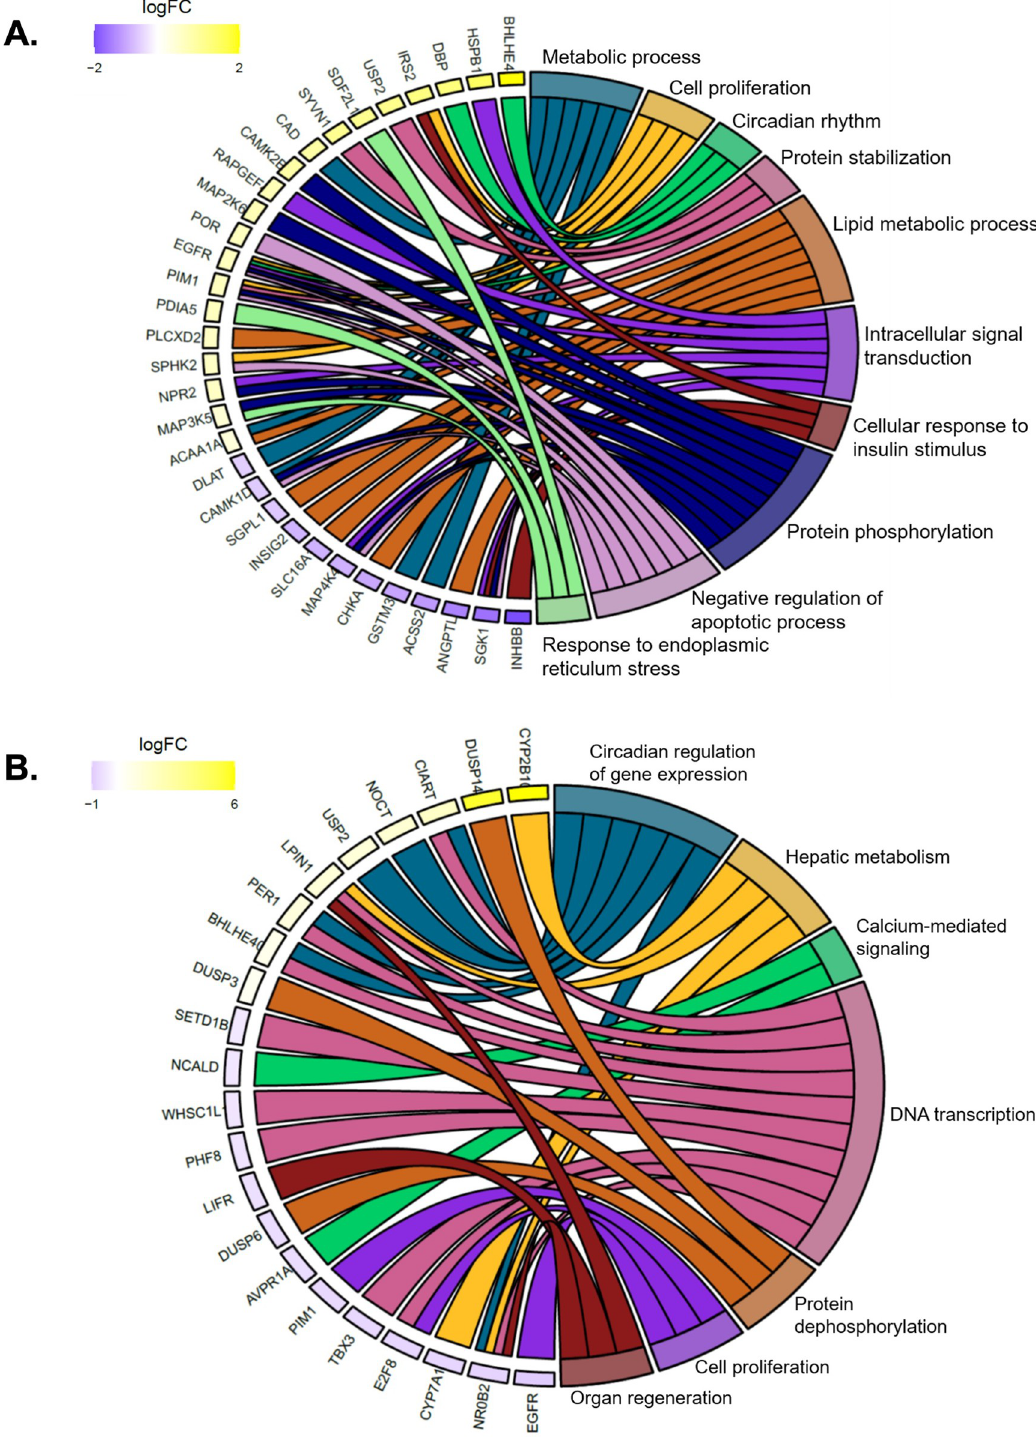
Fig 6. Chord plots displaying relationships between RNAseq gene expression data and gene ontology. Chord plots were used to display the relationship between enriched GO terms and differential gene expression data in female (A) and male (B) mice.